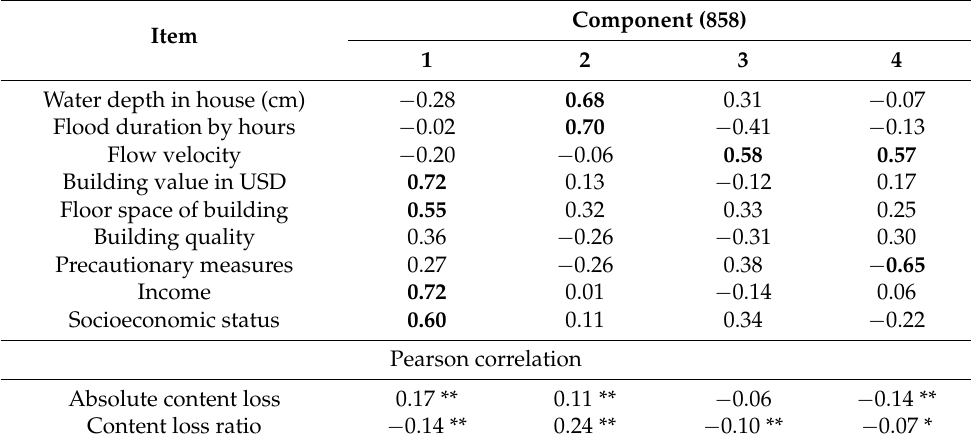
Table 10. Component loading variables that influence content